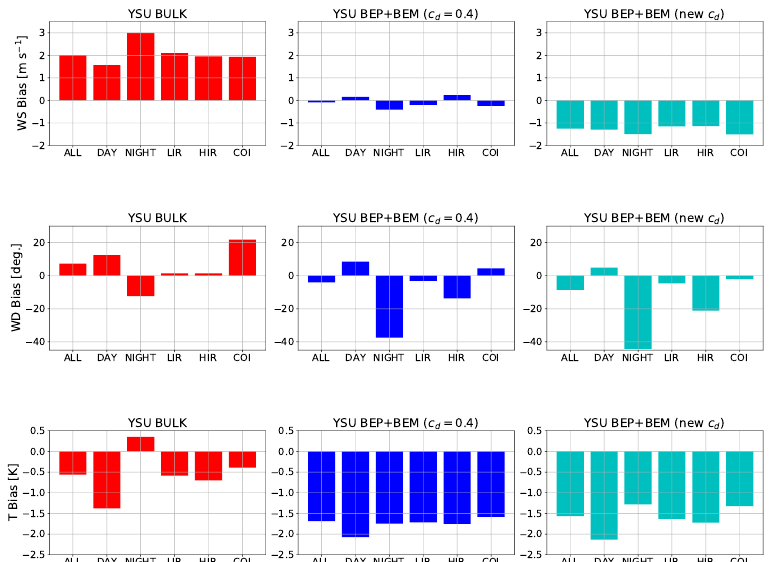
Figure 14. Biases in near-surface wind speed (WS), wind direction (WD), and temperature (T), in each of the three simulations against the TCEQ measurements. Biases are stratified by day versus night, and for each urban class (LIR, HIR, and COI).